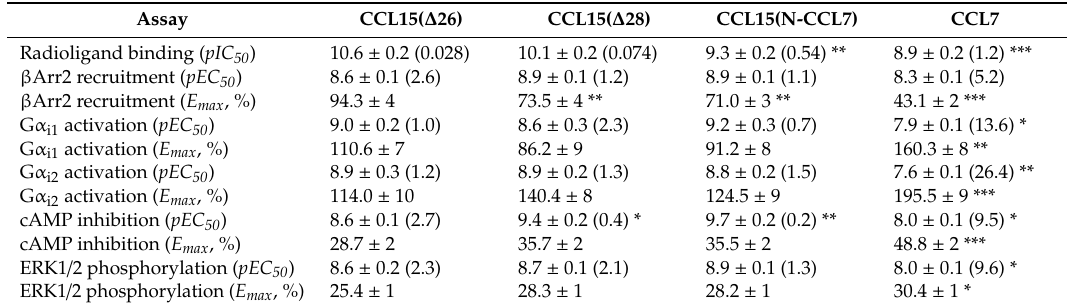
Table 3. A ffi nity, potency, and e ffi cacy of chemokine N-terminal variants at CCR1 1